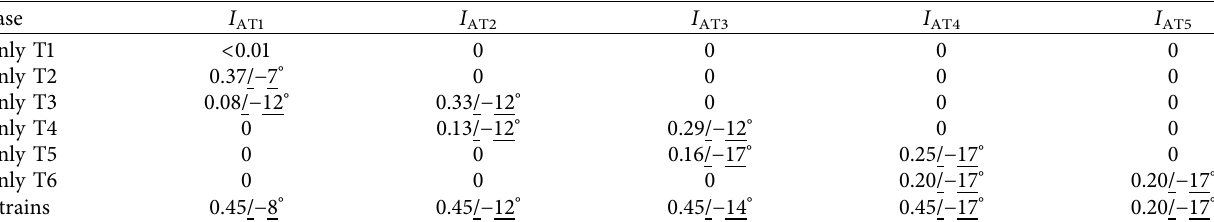
Figure 8: Main distributions of currents as a function of train position (m) for the example with only one train and ideal autotransformers. Table 1: Autotransformer currents (in pu) for the example with six trains and ideal